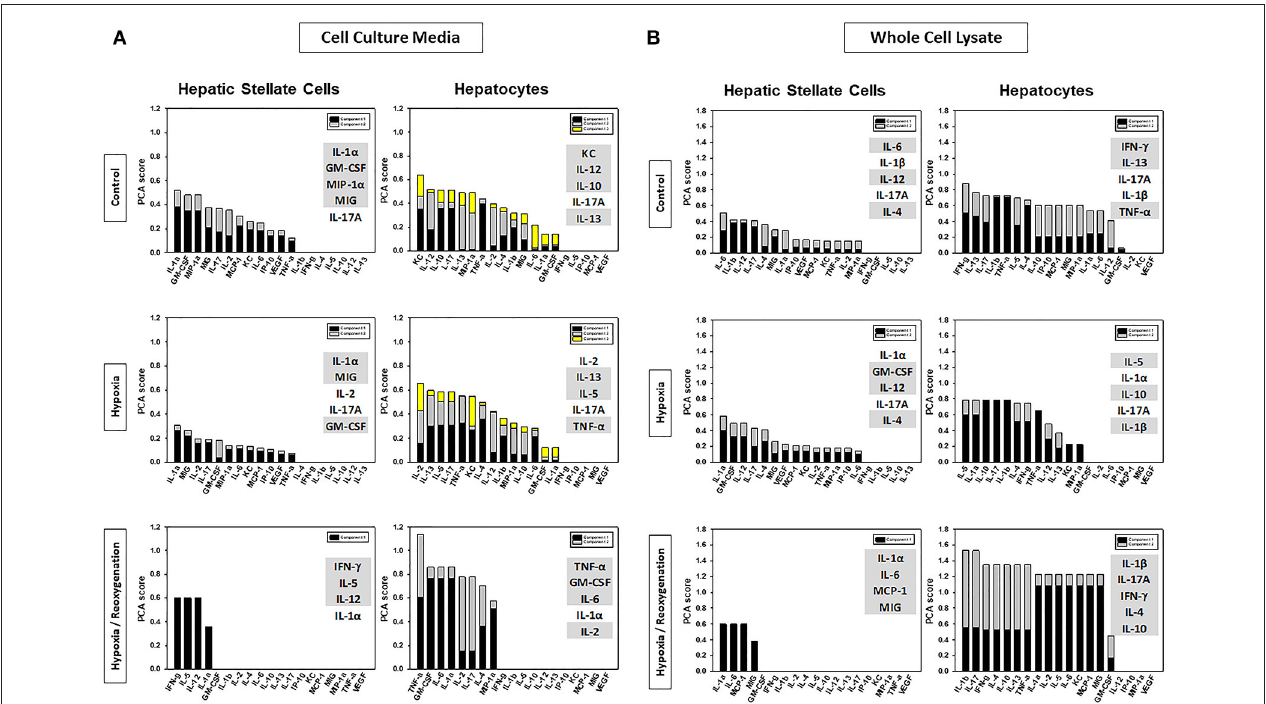
FIGURE 4 | Comparison of HSC and HC based on Principal Component Analysis (PCA). Freshly isolated HSC and HC from C57BL/6 mice were cultured under 21% O 2 for 6h (control), hypoxia (1% O 2 ) for 6h or hypoxia (6h) followed by reoxygenation for 18h. Inflammatory mediators were measured by Luminex TM in both cell culture media (CCM) and whole cell lysate (WCL) and PCA was performed as described in Materials and Methods. Highlighted are the top five inflammatory mediators that contributed the most to the overall variance of the inflammatory response for each experimental condition in CCM (A) and WCL (B)